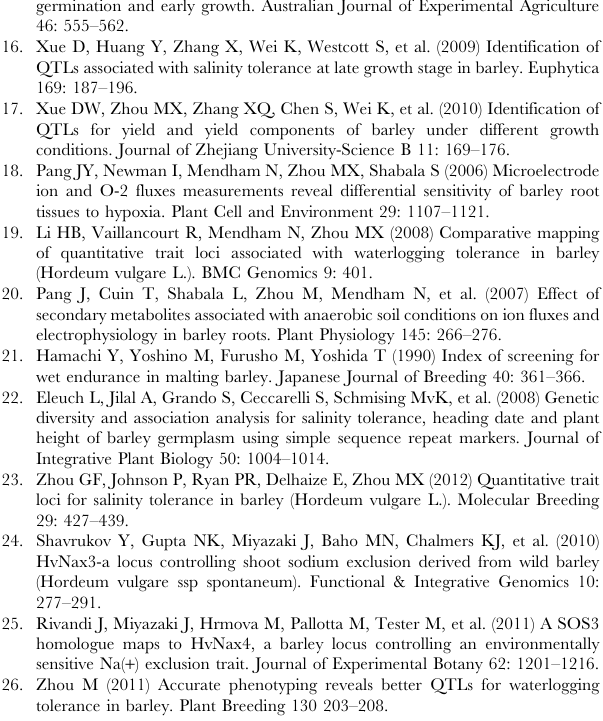
Table S1 listed candidate genes in Brachypodium and rice genomes syntenic to salinity tolerance QTL on barley chromosome 2H. In total, the salinity tolerance QTL region contains 113 Brachypodium and 110 rice annotated genes, and the genes are ordered based on the Barley Genome Zipper [44]. The top border of the QTL could be clearly defined to syntenic regions of the rice chromosome 4 and Brachypodium chromosome 5. The bottom border may locate in a translocation region of rice chromosomes 4 and 7 (Table S1). Several transporter genes, e.g.Bradi5g02750, Bradi5g02520 and Bradi5g25010, or vacuolar-sorting receptor gene Bradig17670 may be the candidate genes for the salinity tolerance in this QTL.